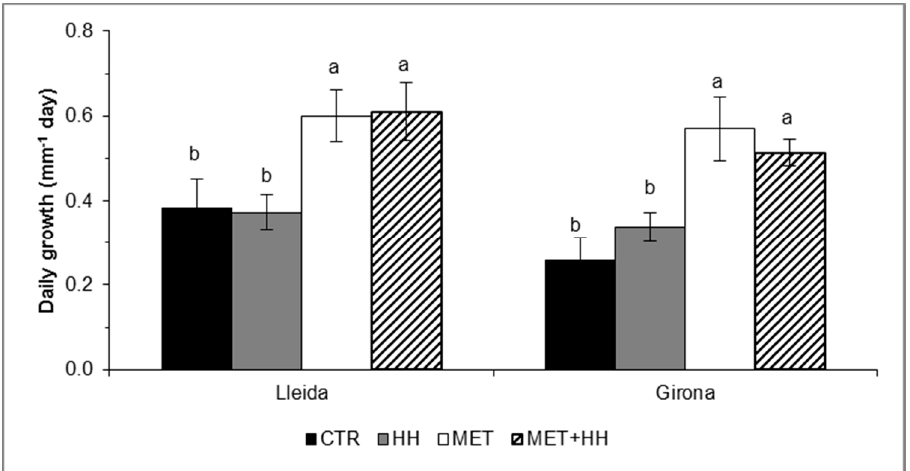
Figure 4. The daily shoot growth rate (mm − 1 day) evaluated 10 days after spraying (DAS), in the trials with ‘Golden Reinders’ apple at Lleida and Girona, Spain. Mean values ± SE ( n = 32) followed by different letters express significant differences between treatments within each day using Tukey’s HSD test ( α ≤ 0.05). Control (CTR), increased relative humidity for 3 h prior spraying (HH), metamitron 247.5 mg/L (MET), and their combination (MET+HH).